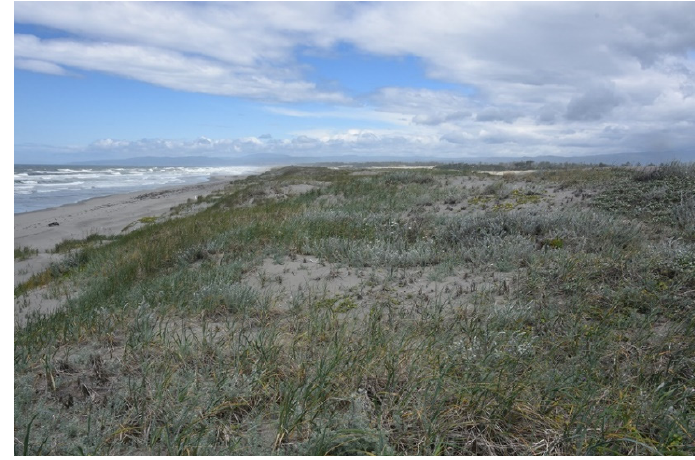
Figure 2. Dune mat community on foredune.